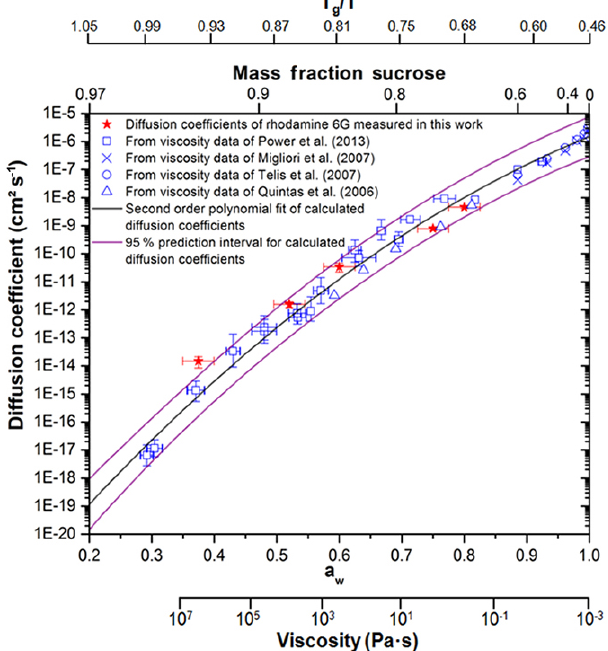
Figure 6. A comparison of measured diffusion coefficients of rho- damine 6G in sucrose–water films from this work (red stars) with predicted diffusion coefficients based on measured viscosities of sucrose–water solutions and the Stokes–Einstein equation from Power et al. (2013) (blue squares), Migliori et al. (2007) (blue crosses), Telis et al. (2007) (blue circles) and Quintas et al. (2006) (blue triangles). The x error bars for this work correspond to the uncertainty in the determination of a w from the hygrometer. The y errors for this work correspond to 95% confidence intervals from measurement repeats. Several different x axes (wt% sucrose, a w , T g /T and viscosity) are included to help put the results in context. T represents the temperature of the experiment (294.5K), and T g represents the glass transition temperature of sucrose–water solu- tions.